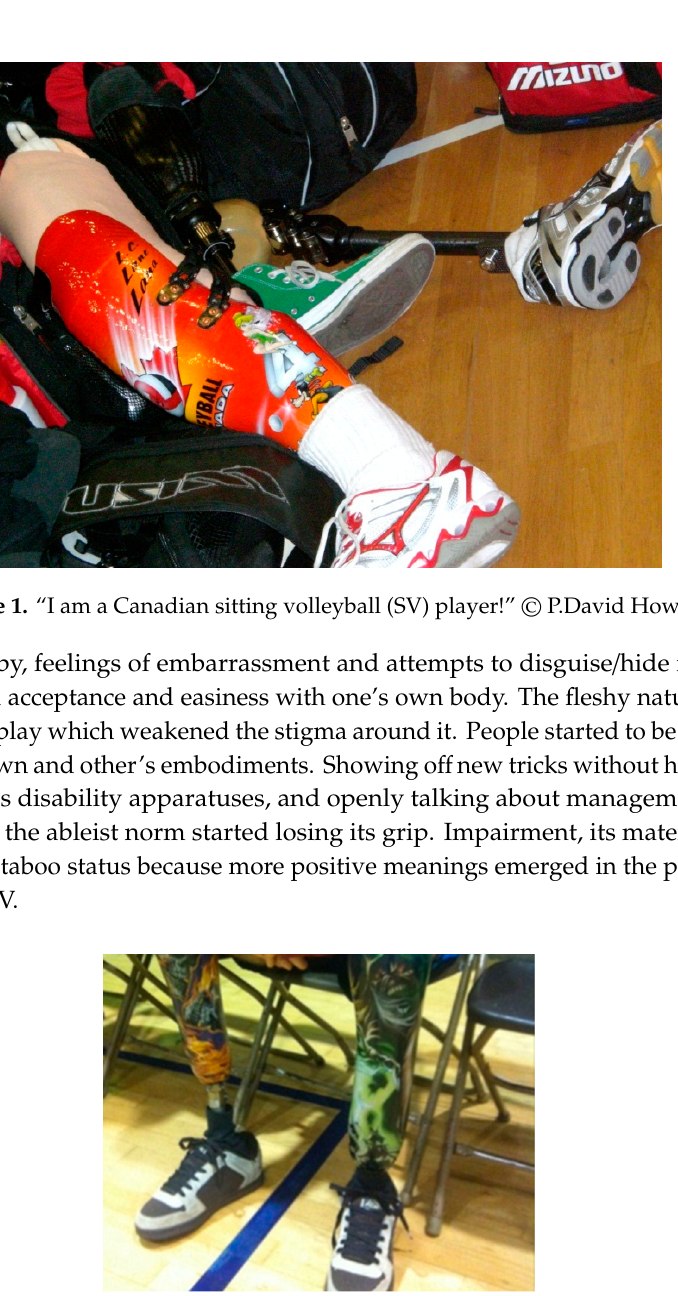
Figure 2. From hiding to “Showing Off”© Carla Filomena Silva